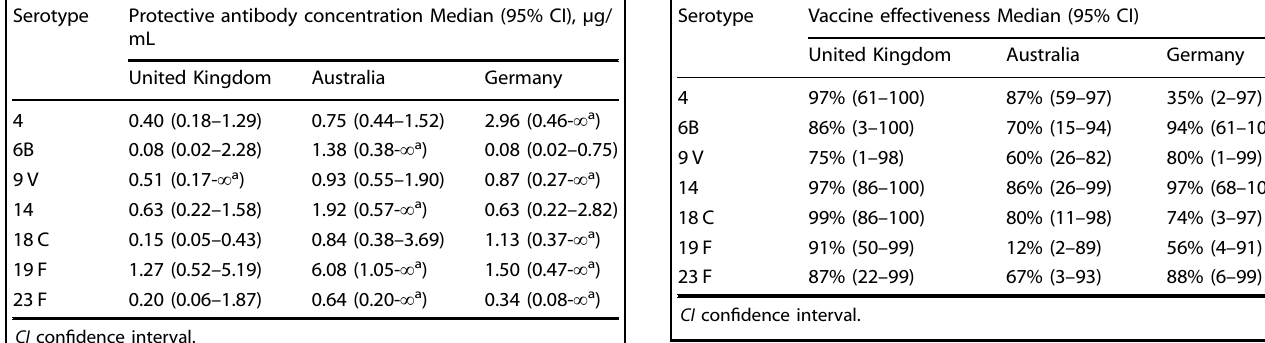
Table 1. Predicted serotype-speci fi c protective antibody concentration for the PCV7 serotypes in PCV13.